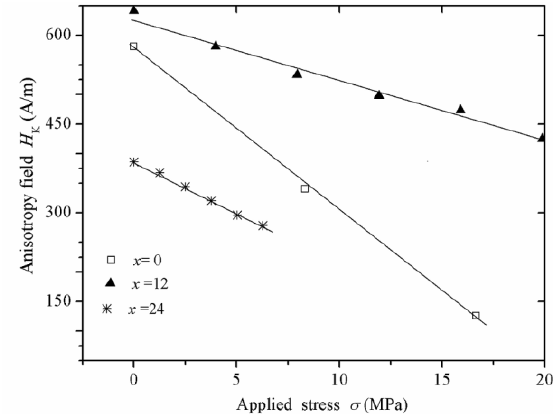
Figure 5. Anisotropy field H alloy series. The straight lines correspond to linear fittings with at least R 2 =